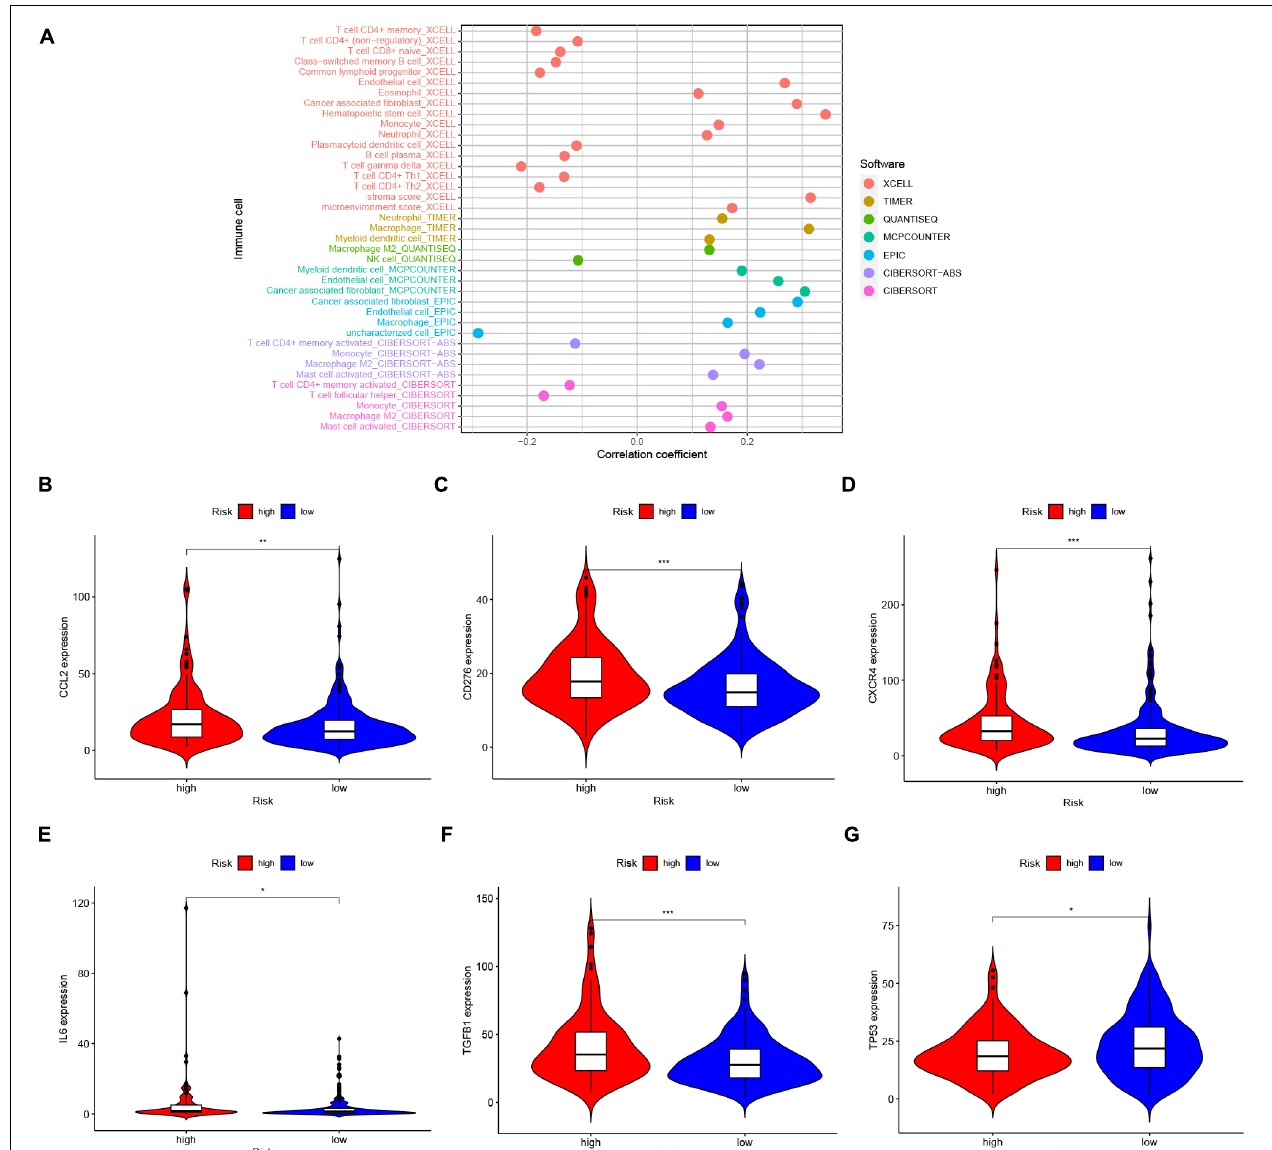
FIGURE 6 | Immune features of IRlncRNAPs signature. (A) Correlation between the riskScore and tumor-infiltrating immune cells, as shown in a lollipop diagram. Expression patterns of the IRGs between high- and low-risk groups, the expression of (B) CCL2, (C) CD276, (D) CXCR4, (E) IL6 , and (F) TGF β 1 increased in the high-risk group and (G) TP53 decreased in high-risk group. * P < 0.05, ** P < 0.01, *** P < 0.001, and ns, no